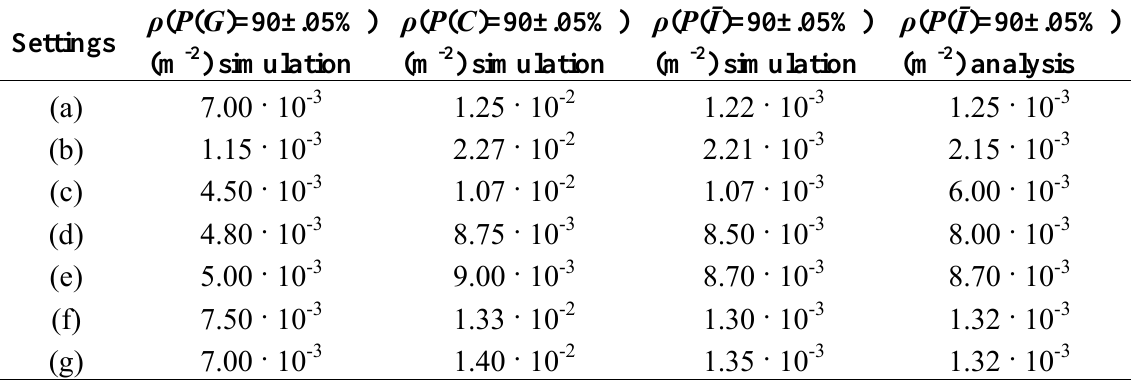
Table 1. Critical density for giant component, one-connectivity and non-isolation under different settings, comparison of analytical and simulation